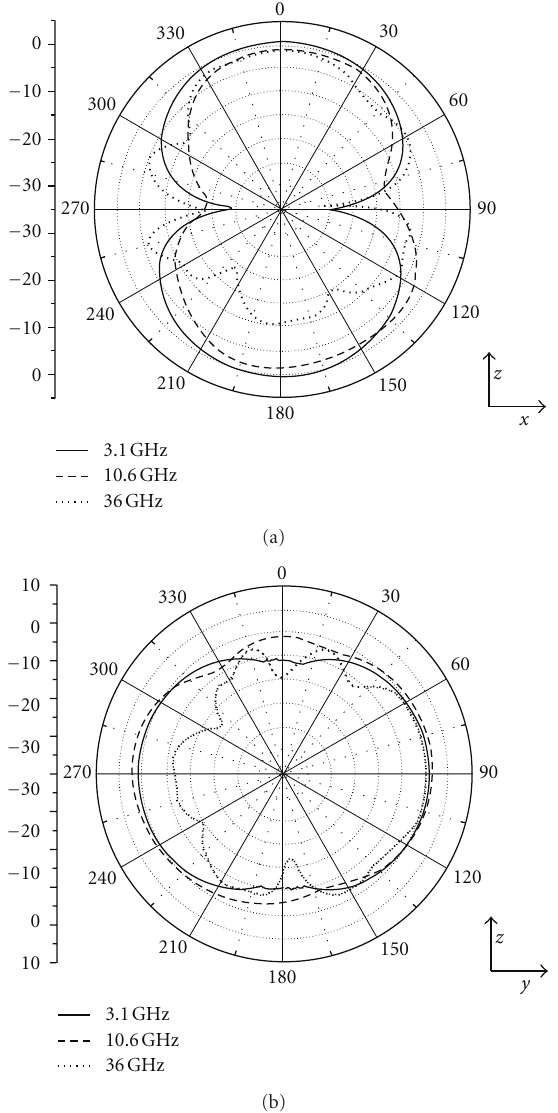
Figure 8: Radiation patterns on E -plane ( x-z plane) and H -plane ( y-z plane) for the dual band-notched antenna 1 at 3.1GHz, 10.6GHz, and 36 GHz: (a) E -plane (b) H -plane.